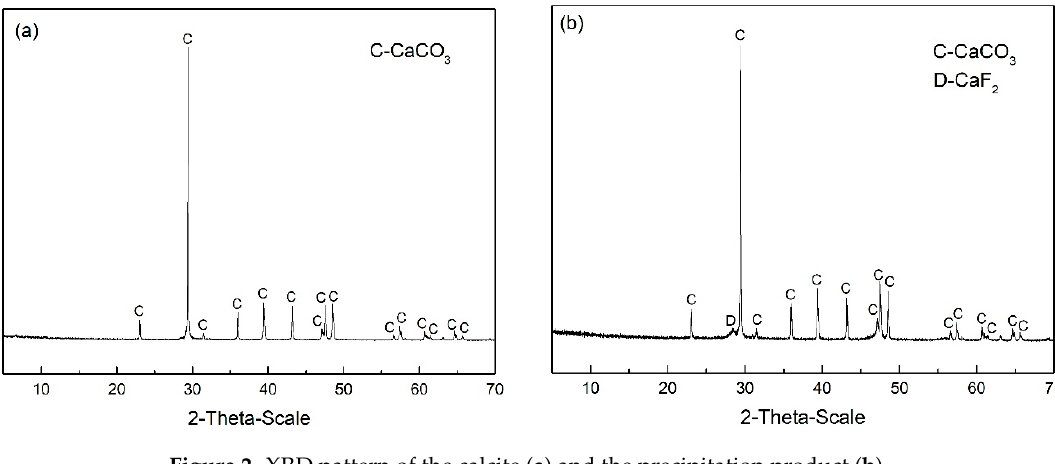
Figure 2. XRD pattern of the calcite ( a ) and the precipitation product ( b ).